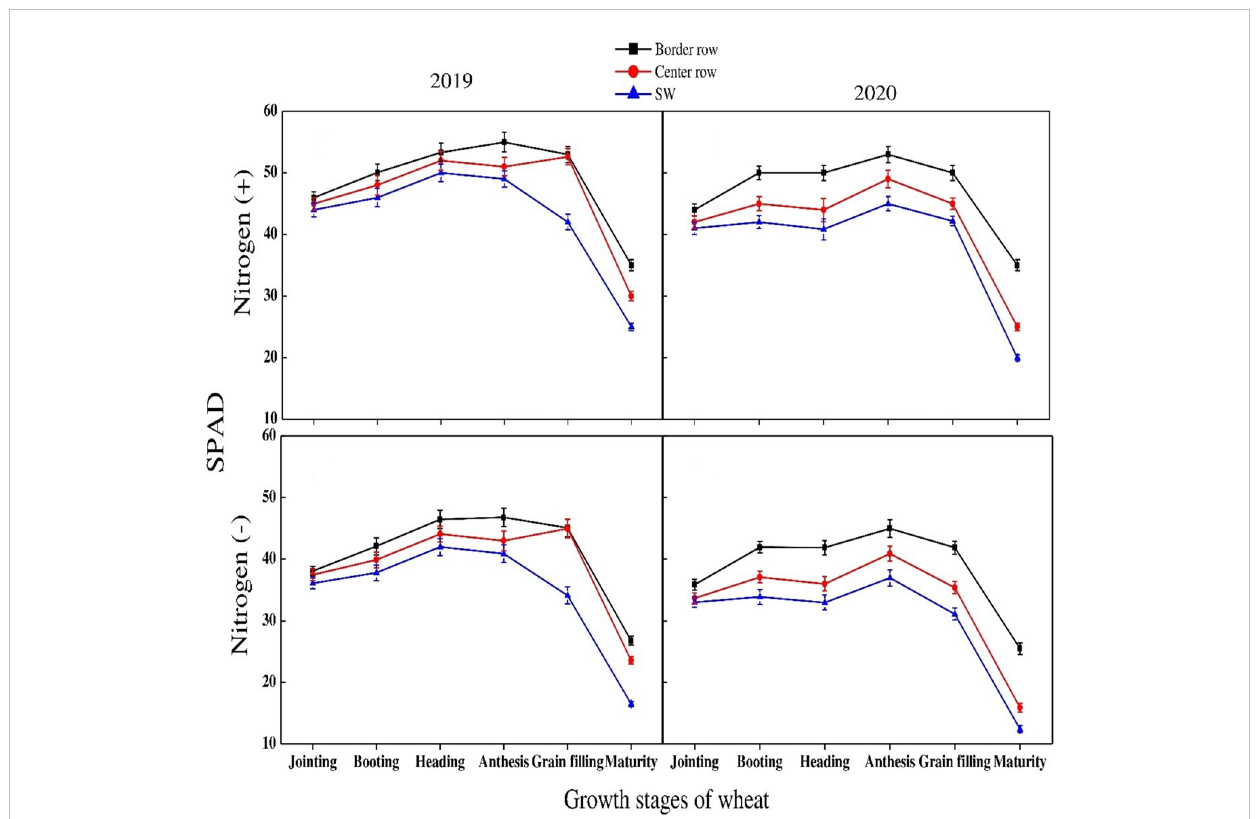
FIGURE 10 SPAD values of the border-, center- and sole wheat (SW) crop at various growth stages under with- and without N application. Different letters on the top of each bar indicate signi fi cant differences among the various crop growth stages, as calculated by Tukey ’ s HSD test at P ≤